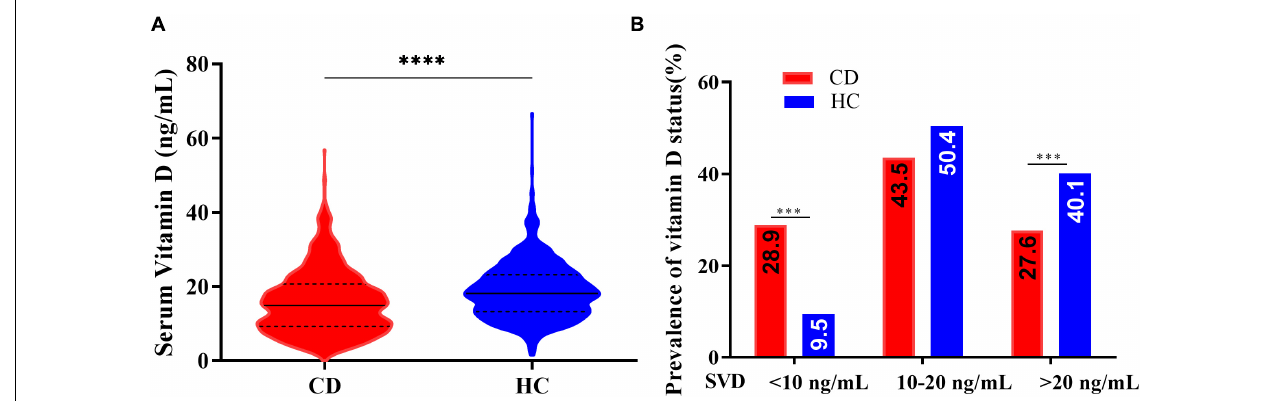
FIGURE 2 | (A) Serum vitamin D concentrations in patients with Crohn’s disease (CD) and healthy controls (HC) (Kolmogorov-Smirnov test, ∗∗∗∗ p < 0.0001). (B) Vitamin D status in patients with Crohn’s disease (CD) and healthy controls (HC) (chi-square test, ∗∗∗ p < 0.005).